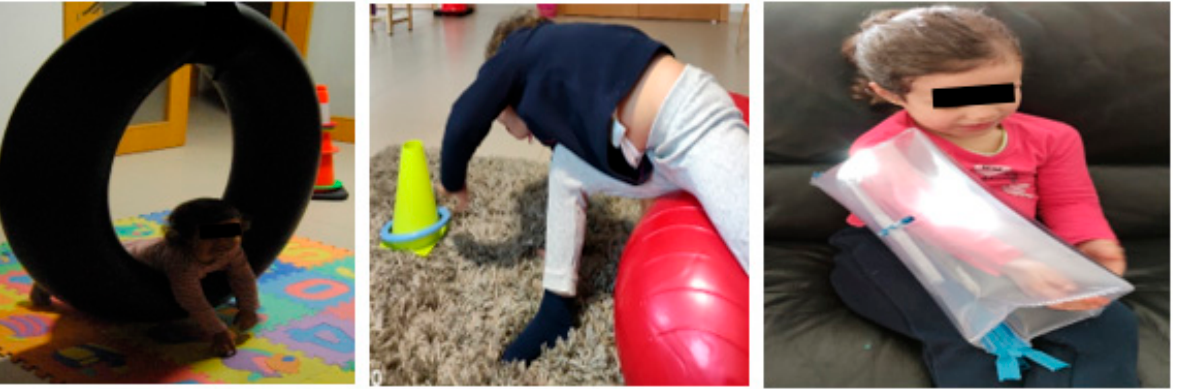
Figure 13. Stretching and use of Urias ® splint.